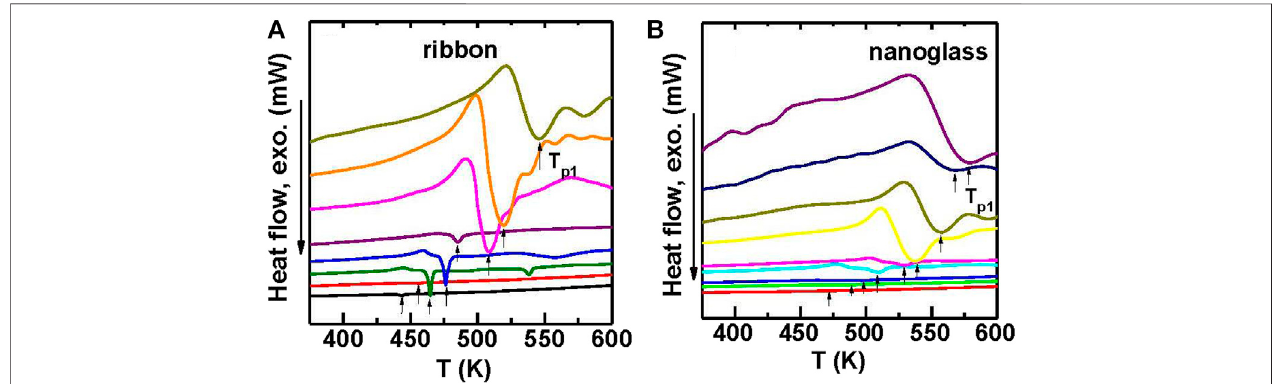
FIGURE 18 | (A) Flash DSC heat fl ow curves with different heating rates of 30, 100, 300, 1,000, 3,000, 6,000, 10,000, 20,000 K/s (from down to top) in the melt- spun